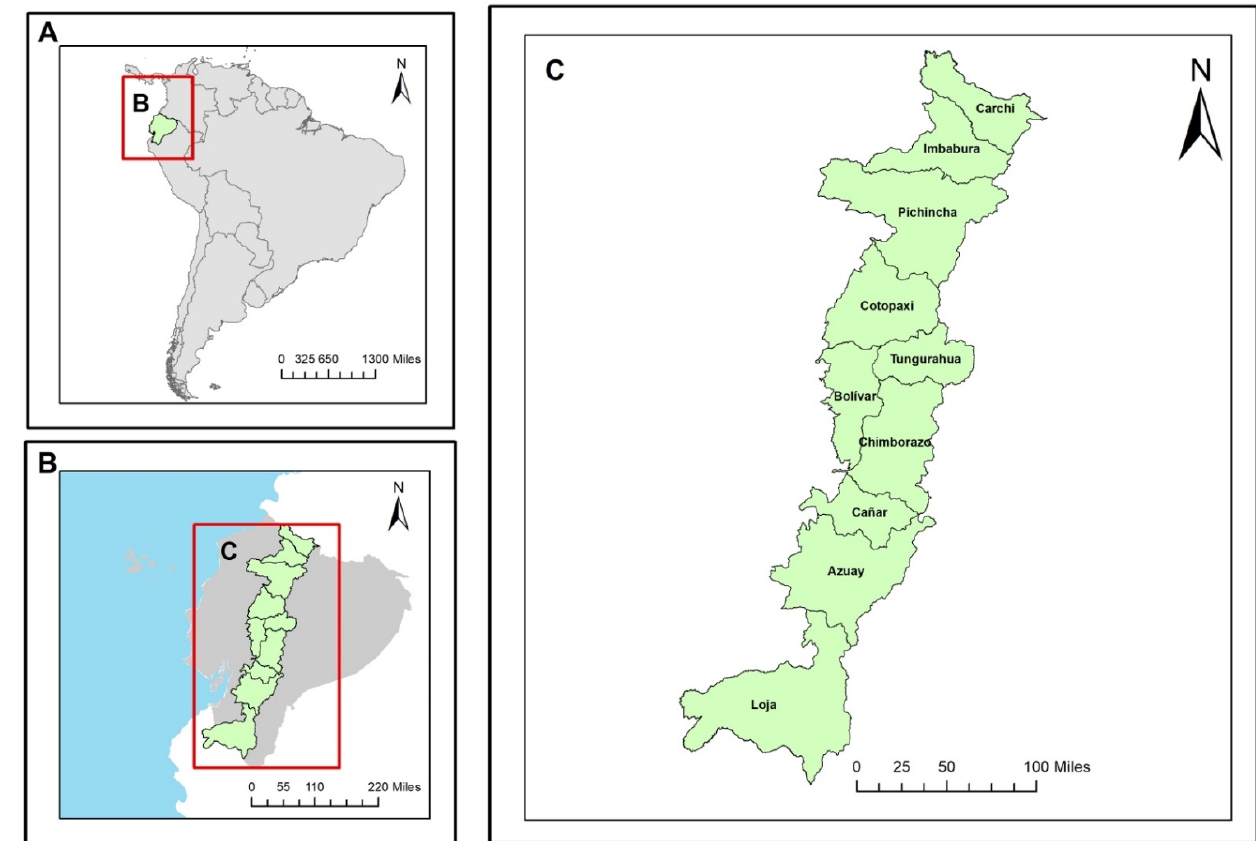
Figure 1. Study area: ( A ) geographical location of Ecuador; ( B ) Andean Region of Ecuador; ( C ) provinces belonging to the Andean region.